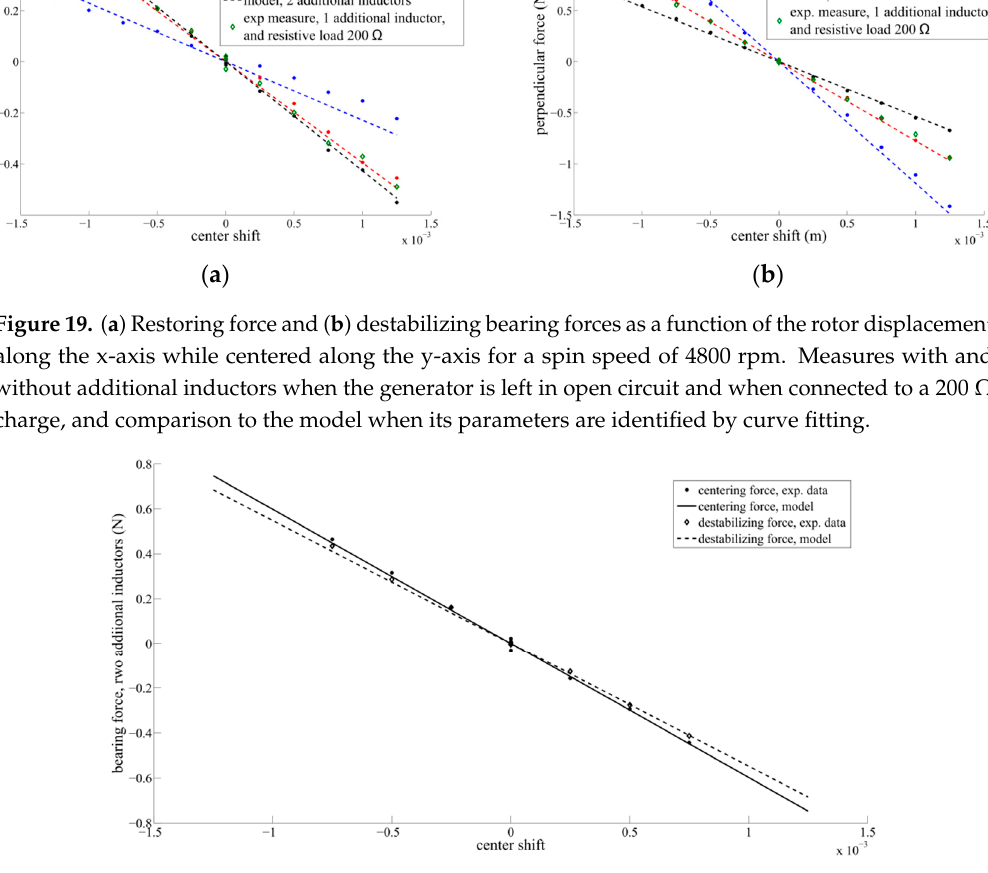
Figure 20. Bearing forces when adding two additional inductors in series with each coil as a function of the center shift for a spin speed of 6600 rpm.